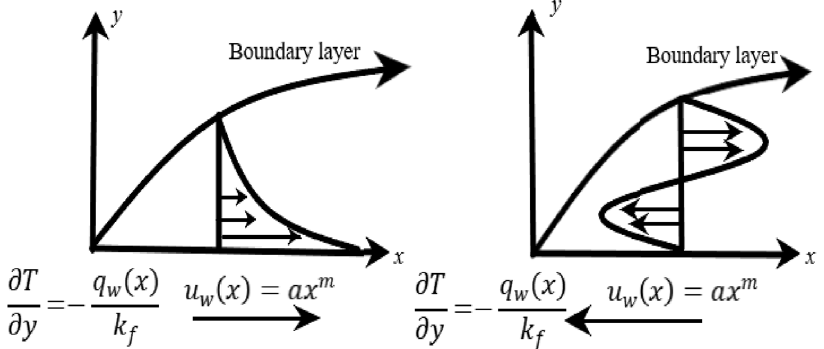
Figure 1. Representation of physical